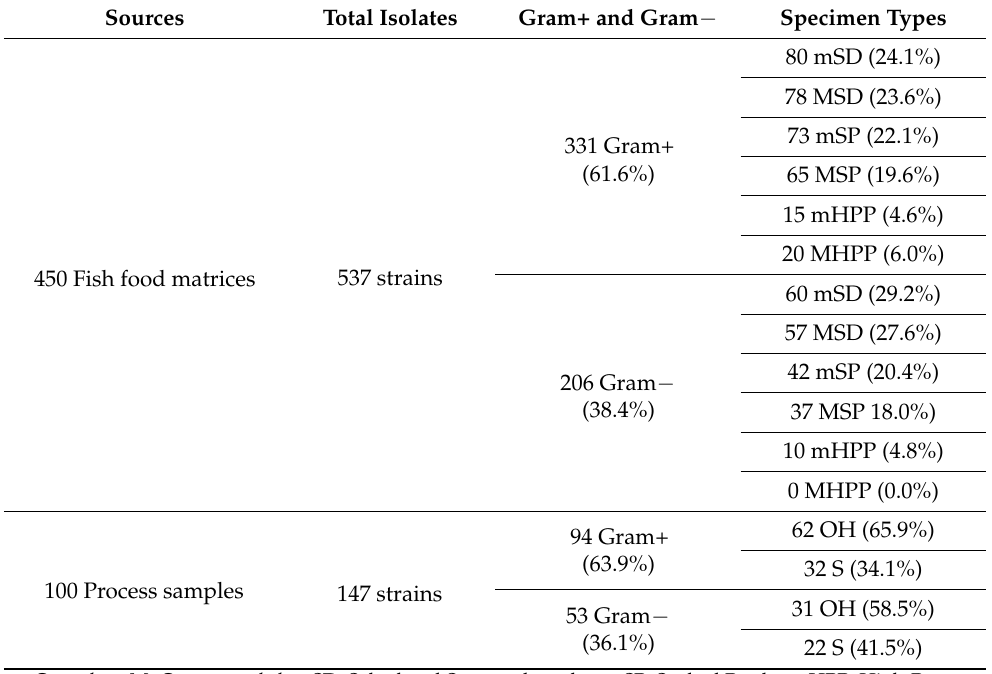
Table 3. Identified bacterial strains in this research